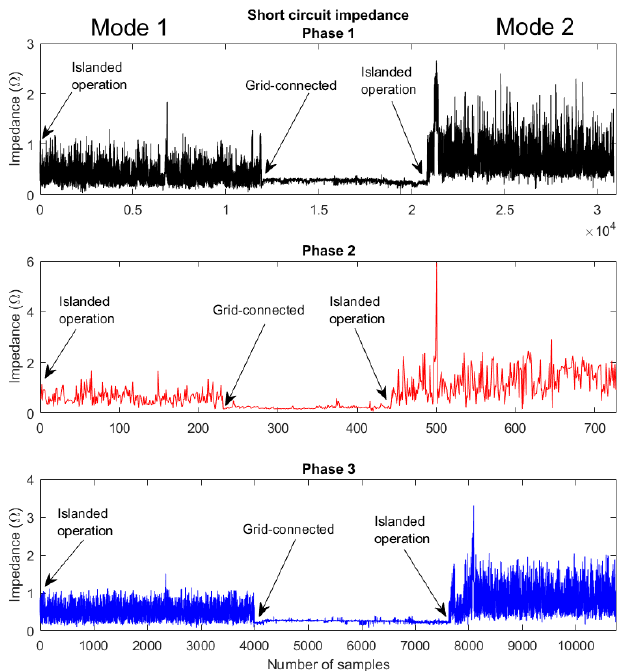
Figure 13 . Short circuit impedance for 13 weeks of islanded and grid-connected measurements. The number of samples are around 31,000, 730 and 11,000 for phase 1 to 3 respectively. Note the difference in horizontal scale for each sub-plot.